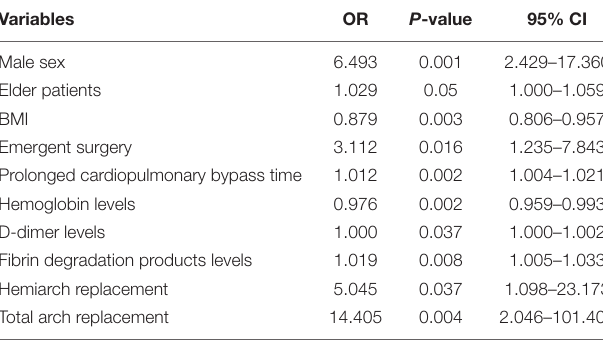
TABLE 3 | Risk factors of postoperative massive bleeding.